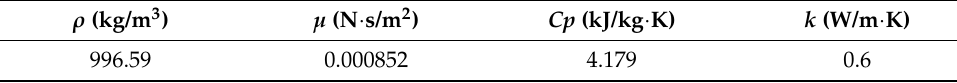
Table 1. Physical properties of water at temperature of 300 K [23,29].